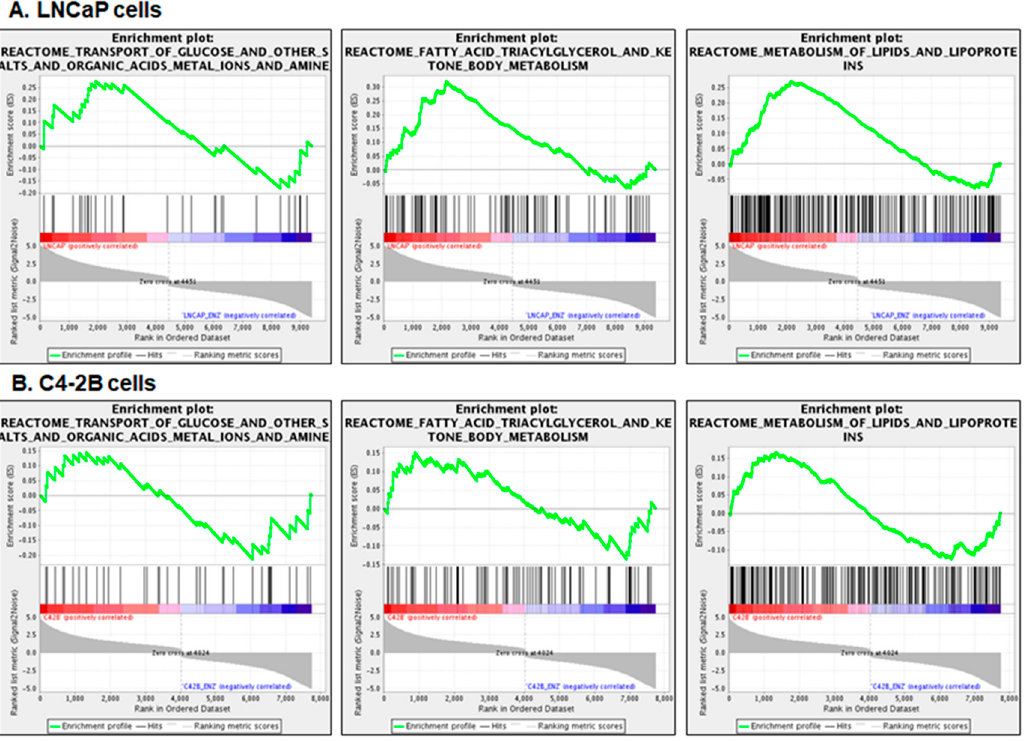
Figure 6. Gene set enrichment analysis. ( A ) LNCaP enzalutamide resistant cells and ( B ) C4-2B enzalutamide resistant cells compared to their parental counterparts at a threshold of FDR p -value < 0.05. Enriched pathway includes fatty acid metabolism, glucose transport, and metabolism of lipid and lipoproteins. The green curve corresponds to the enrichment score (ES), which is the running sum of the weighted enrichment score obtained from GSEA software. Red and blue color bar display the positive and negative regulated genes.